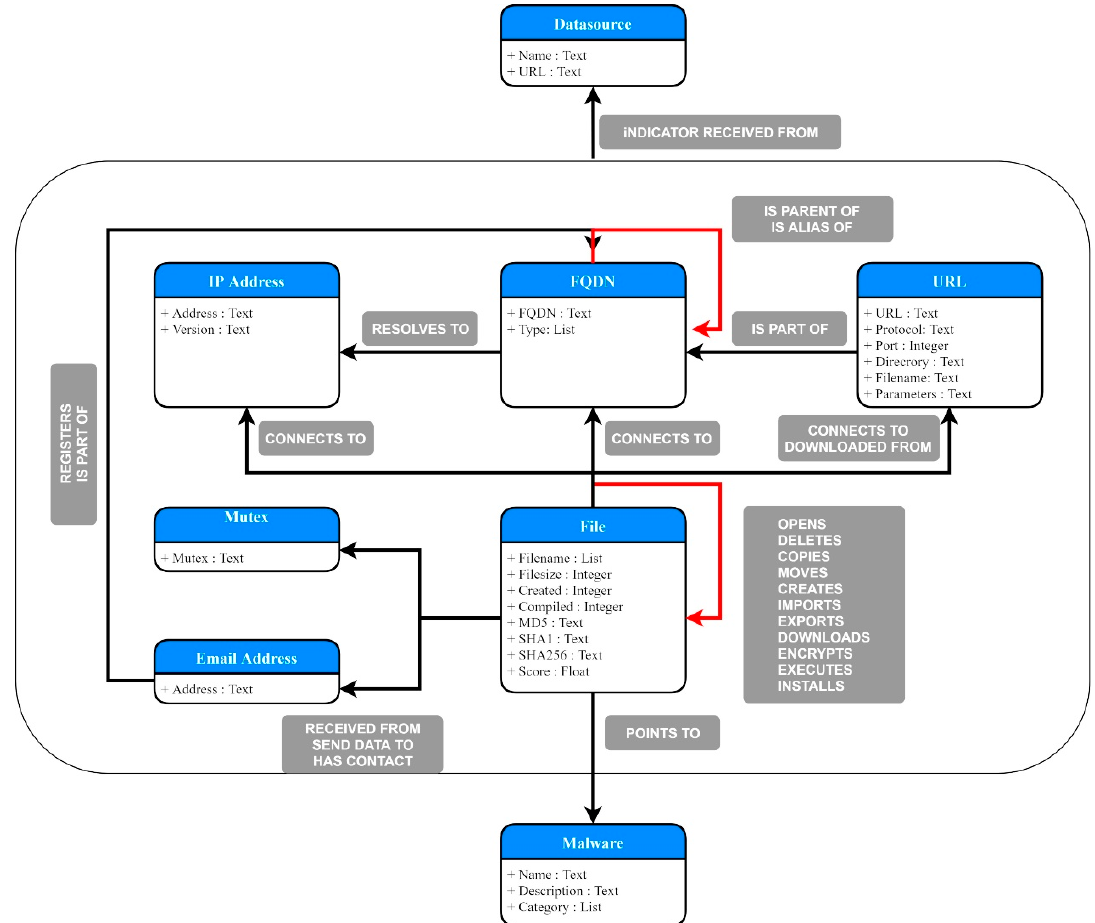
Figure 3. The local IoC database schema [6].